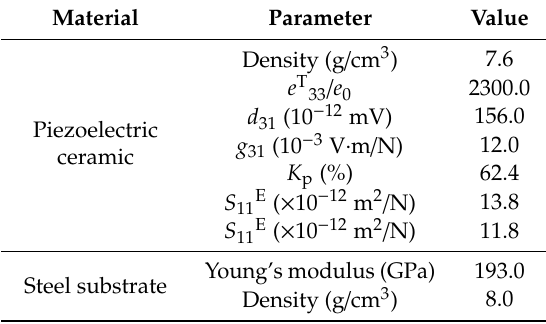
Figure 2. Schematics of ( a ) the piezoelectric device and ( b ) the piezoelectric energy harvester. Table 1. Material properties of the piezoelectric device.